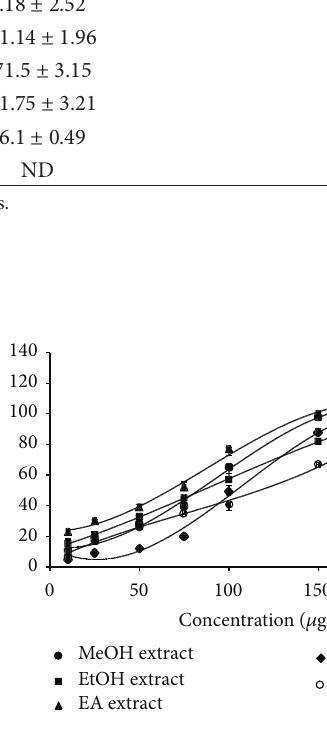
Figure 1: Cytotoxic activity of various solvent extracts of E. hirta aerial part on Vero cell line. The results were expressed as mean ± SD of triplicate